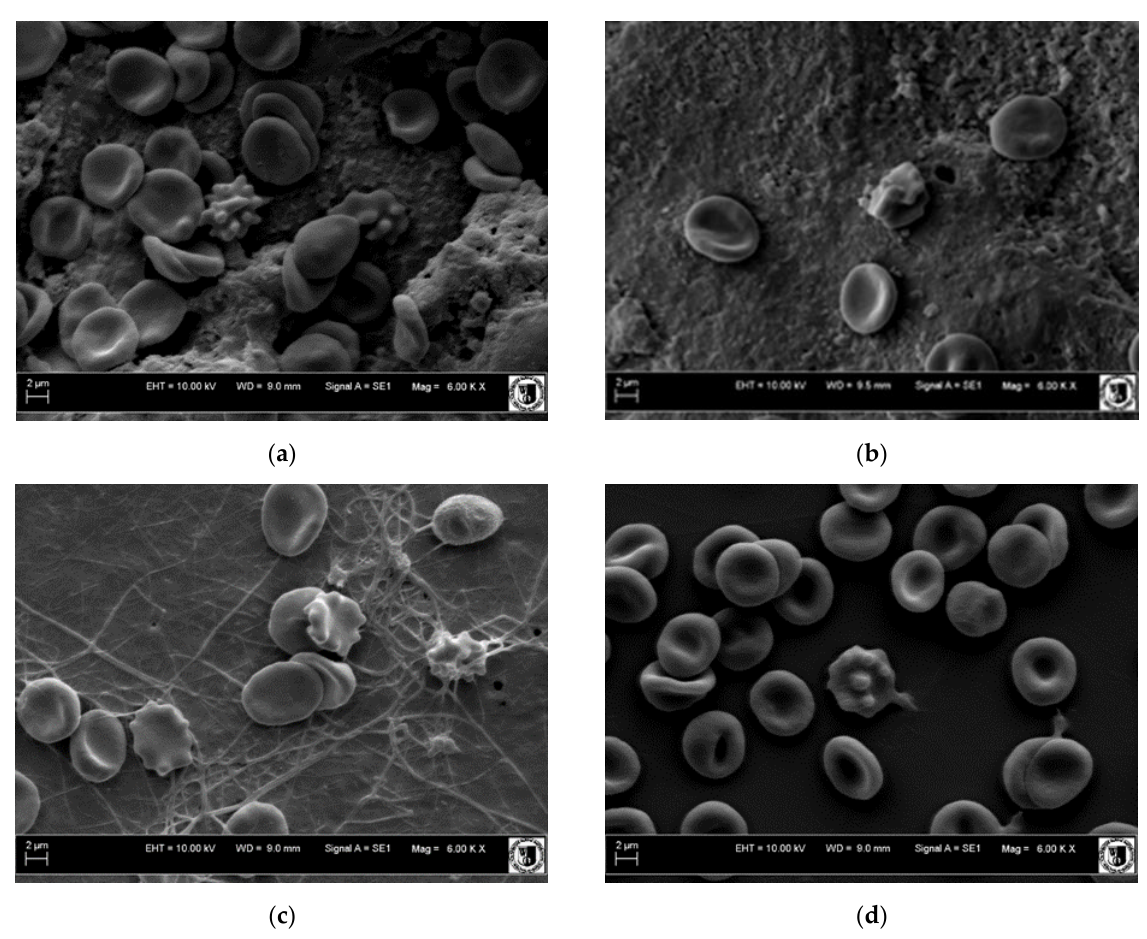
Figure 17. Surface of tested materials after contact with solid blood. Co-Cr disc with graphene ( a ), Co-Cr disc without graphene ( b ), nitrile rubber ( c ), high-density polyethylene (HDPE) ( d ). Magnification 6000×.